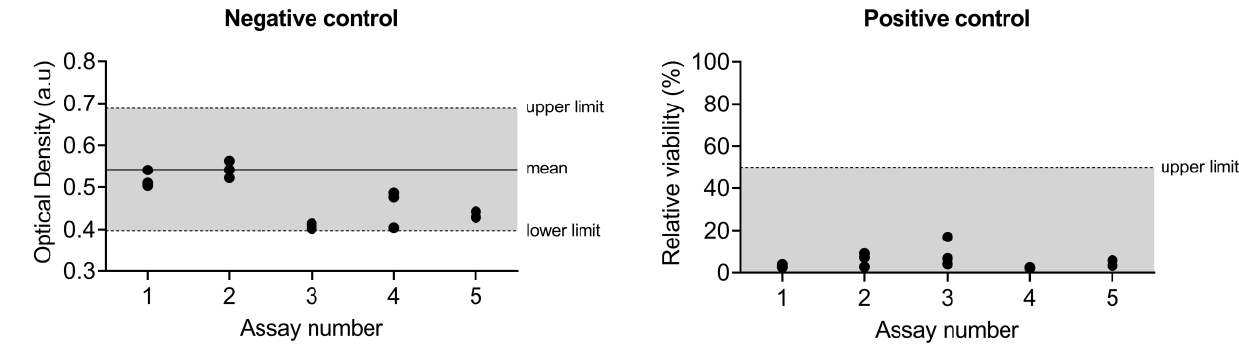
Figure 4. Negative and positive quality control data of the different assays included in this study.